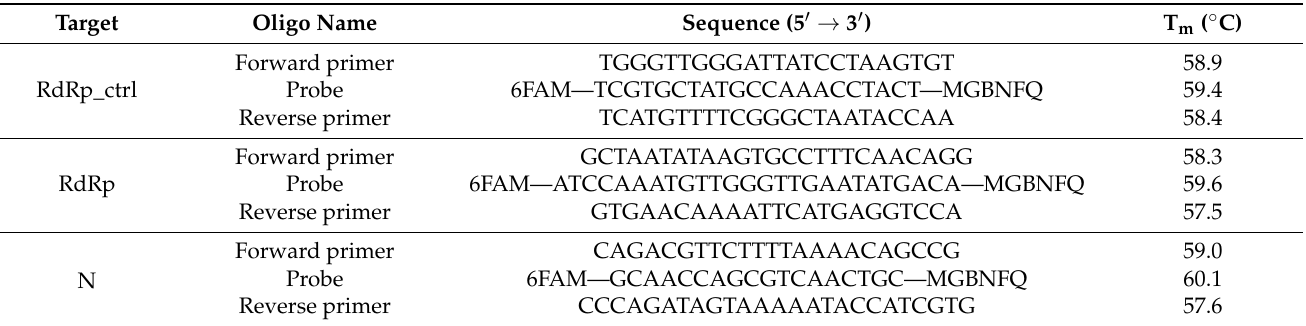
Table 2. RT-qPCR oligo sequences. 6FAM = 6-carboxyfluorescein; MGBNFQ = minor groove binder non-fluorescent quencher.